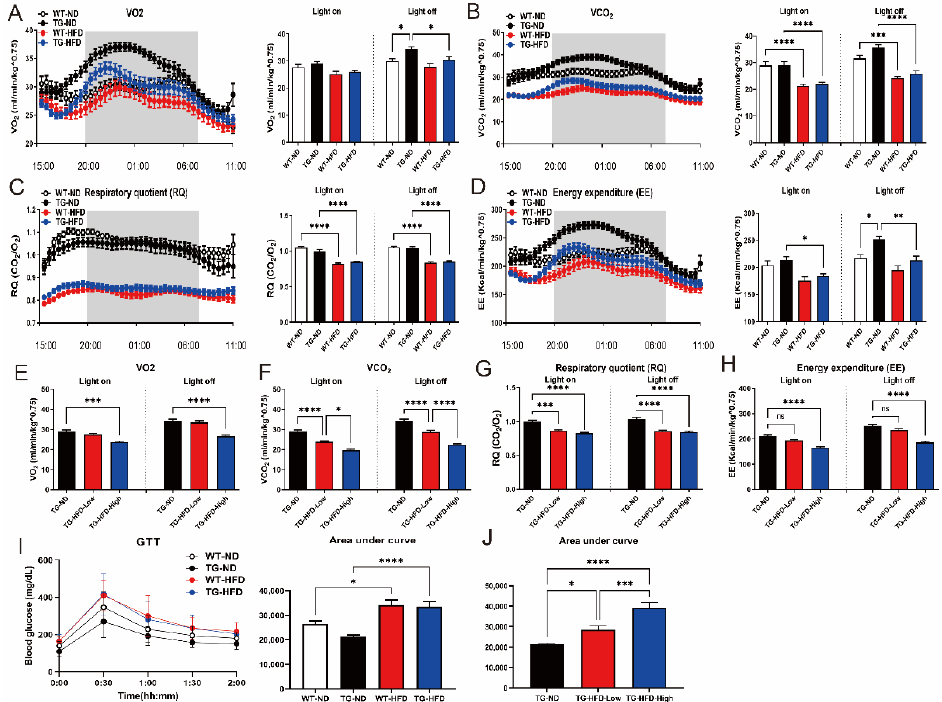
Figure 2. Analysis of the metabolic changes under a high-fat diet (HFD) by indirect calorimetry and the glucose tolerance test (GTT) in the 5XFAD Alzheimer’s disease transgenic mouse model. Analysis of oxygen consumption (vO2) normalized to the body weight in female mice, plotted at 30 min intervals during 1 day ( A , left panel), and vO2 in light-on and -off conditions ( A , right panel). Carbon dioxide production (vCO2) plotted at 30 min intervals during 1 day ( B , left panel) and vCO2 in light-on and -off conditions ( B , right panel). Respiratory quotient (RQ) plotted at 30 min intervals during 1 day ( C , left panel) and RQ in light-on and -off conditions ( C , right panel). Energy expenditure (EE) plotted at 30 min intervals during 1 day ( D , left panel) and EE in light-on and -off conditions ( D , right panel). Analysis of female mice in the divided HFD-fed groups (TG-HFD-High and -Low): vO2 in light-on and -off conditions ( E ), vCO2 in light-on and -off conditions ( F ), RQ in light-on and -off conditions ( G ), and EE in light-on and -off conditions ( H ). Blood glucose levels in female mice ( I , left panel), with an analysis of the area under curve (AUC) in the TD and HFD groups ( I , right panel) and in the divided HFD-fed groups ( J ). ns (not significant), * p < 0.05, ** p < 0.01, *** p <0.001, and **** p < 0.0001 (one-way analysis of variance with Tukey post hoc analysis). Data are presented as the mean ± standard error of the mean. The number of mice in each group ranged 7 – 12. ND, normal chow; WT, wildtype; TG transgenic.